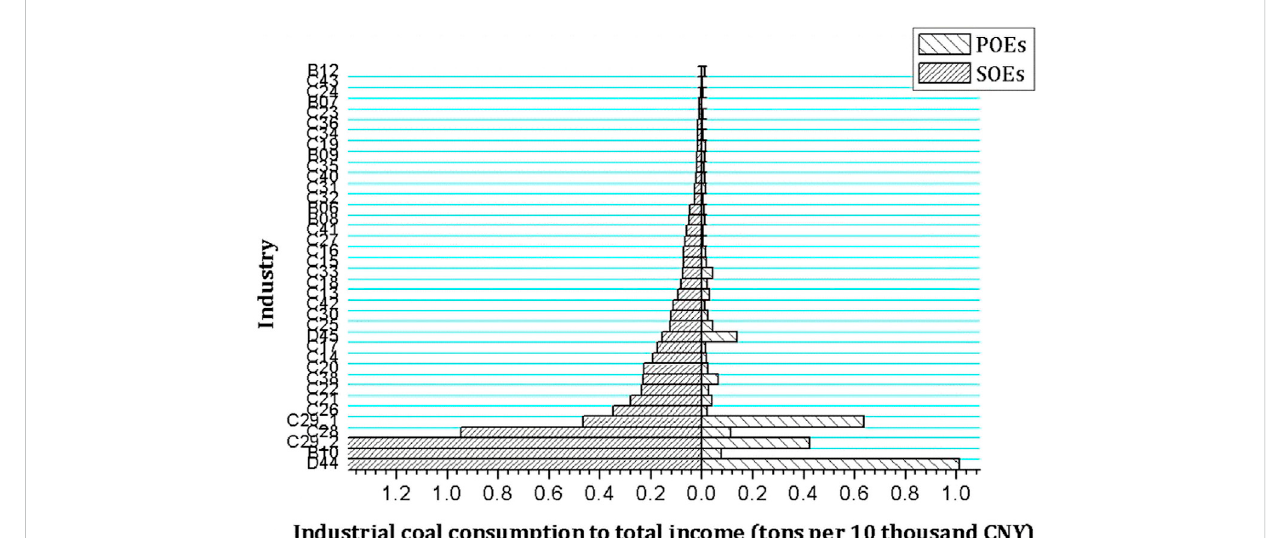
FIGURE 3 Coal consumption to the total revenue in 39 industrial sectors in